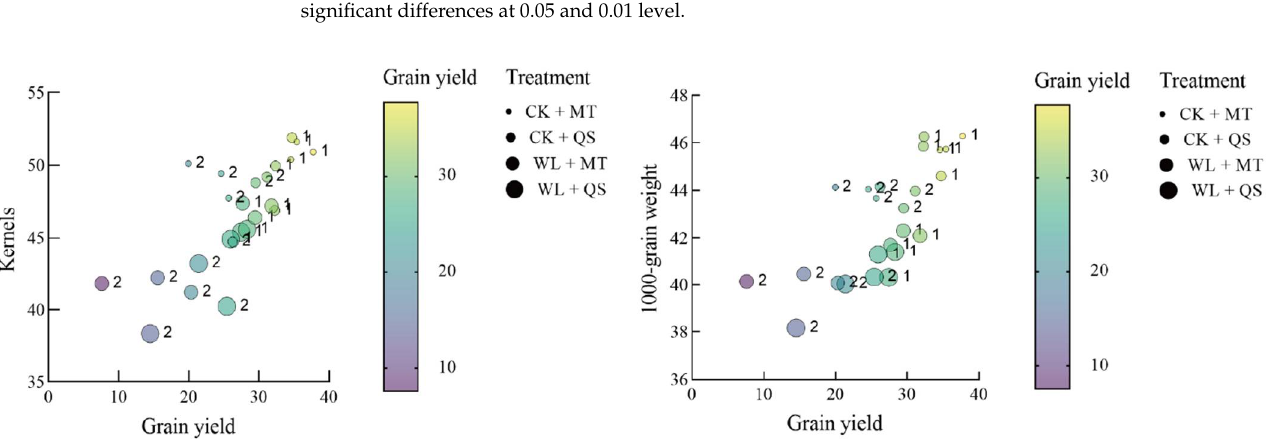
Figure 12. Correlation between wheat root measurement indexes at 7 DAA and yield under differ- ent treatments. Abbreviations: RDW, root dry weight; MDA, malondialdehyde content; SOD, su- peroxide dismutase activity; POD, peroxidase activity; O 2− , superoxide anion production rate; PDC, pyruvate decarboxylase activity; LDH, lactate dehydrogenase activity; ADH, alcohol dehydrogen- ase activity. 4. Discussion Under normal conditions, the production and scavenging of reactive oxygen species in plants are in a dynamic balance, but environmental stress breaks this balance and the